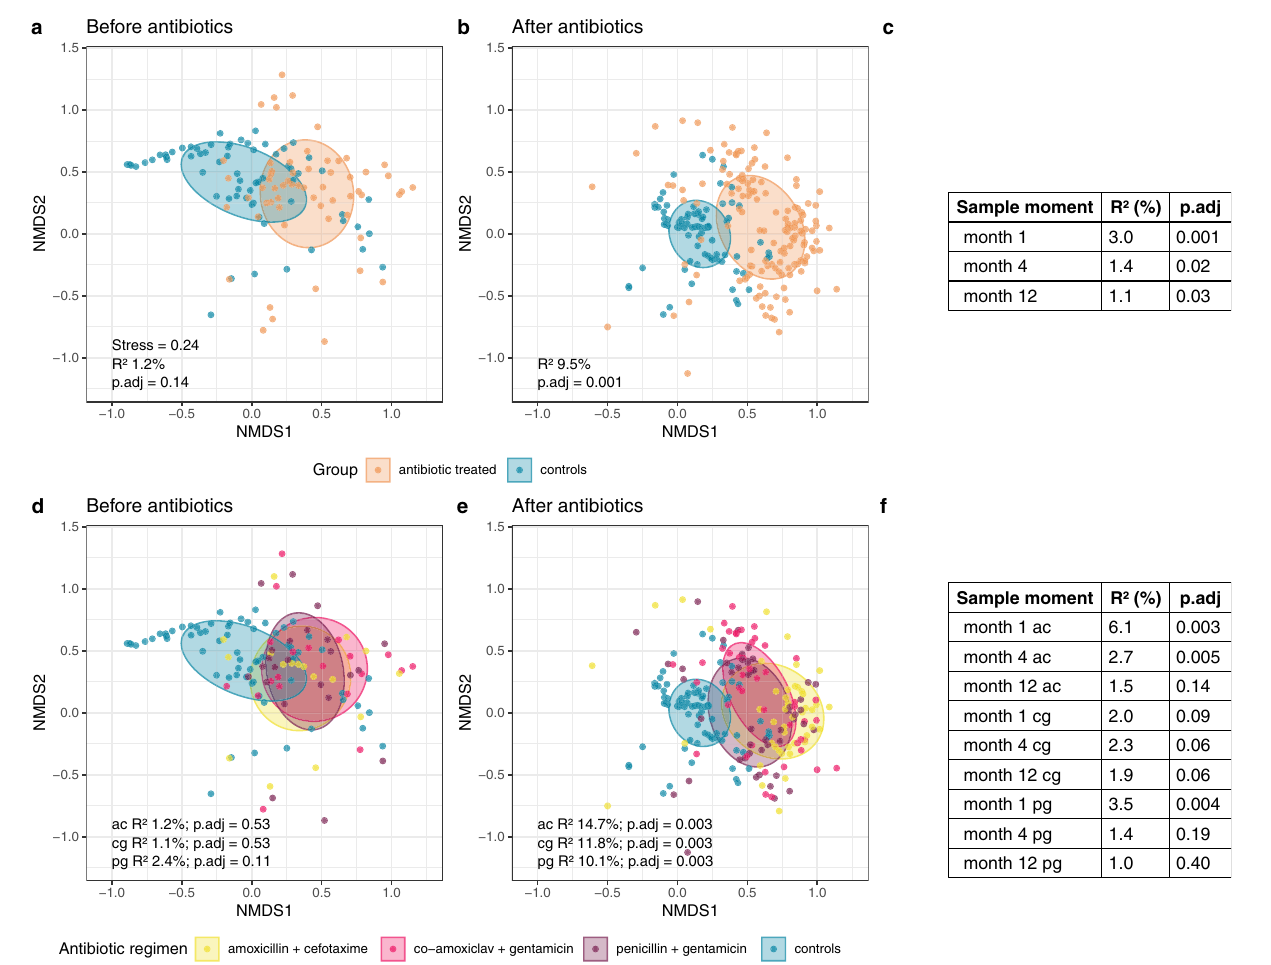
Fig. 2 NMDS plots of overall gut microbiota composition strati fi ed per regimen and time point. Non-metric multidimensional scaling (nMDS), based on Bray – Curtis (BC) dissimilarity between samples, visualizing the overall gut microbial community composition strati fi ed for antibiotic-treated infants and controls ( a , b ) and per regimen compared with controls ( d , e ), for the time points before and immediately after cessation of antibiotic treatment. Each data point represents the microbial community composition of one sample. The ellipses represent the standard deviation of data points belonging to each group, with the center points of the ellipses calculated using the mean of the coordinates per group. The stress of the ordination, effect sizes ( R 2 ) calculated by permutational multivariate analysis of variance (PERMANOVA)-tests and corresponding adjusted p -values ( p .adj, calculated using the Benjamini-Hochberg method) are shown in the plots. In panels c and f the results of the PERMANOVA-tests for the later time points are summarized. Ac = amoxicillin + cefotaxime (yellow), cg = co-amoxiclav + gentamicin (pink), pg = penicillin + gentamicin (purple). Data points of controls are colored teal and those of antibiotic-treated infants (not-strati fi ed per regimen) orange. Source data are provided as a Source Data fi